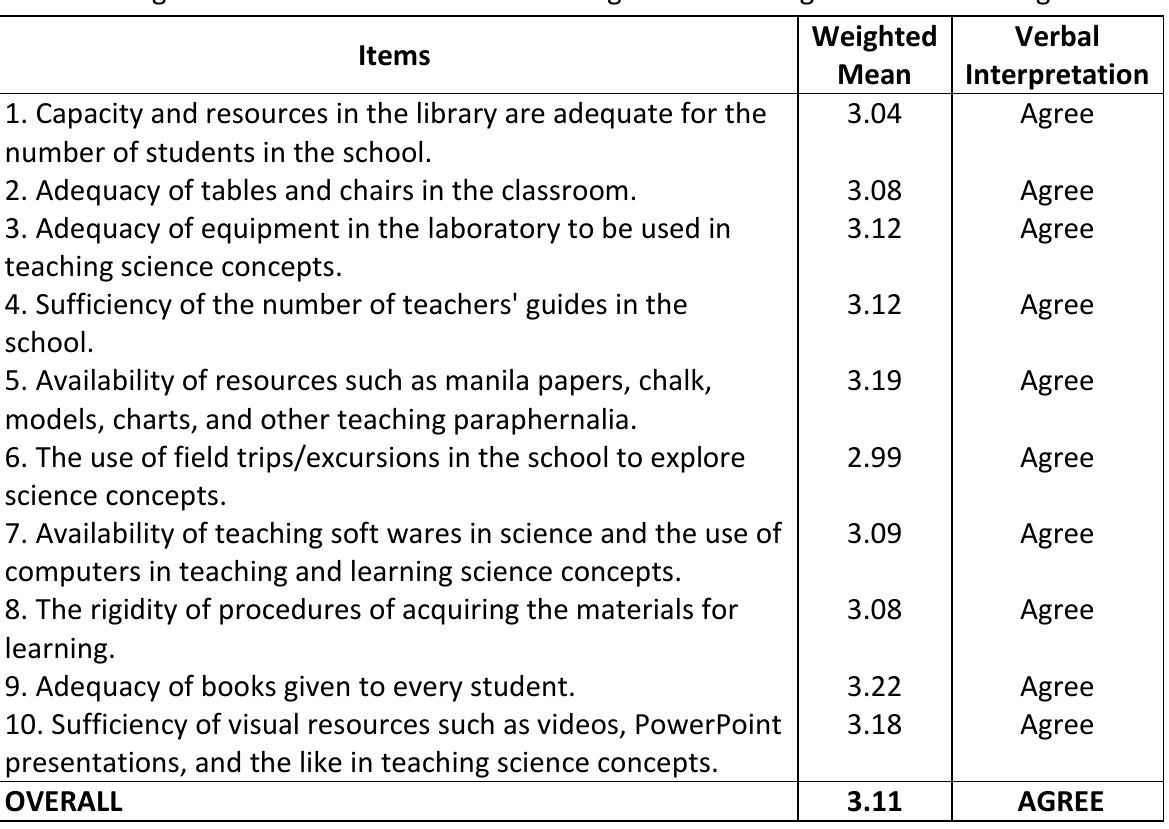
Table 11 : Weighted Means of the Factors Affecting Students’ Progre ss as to Learning